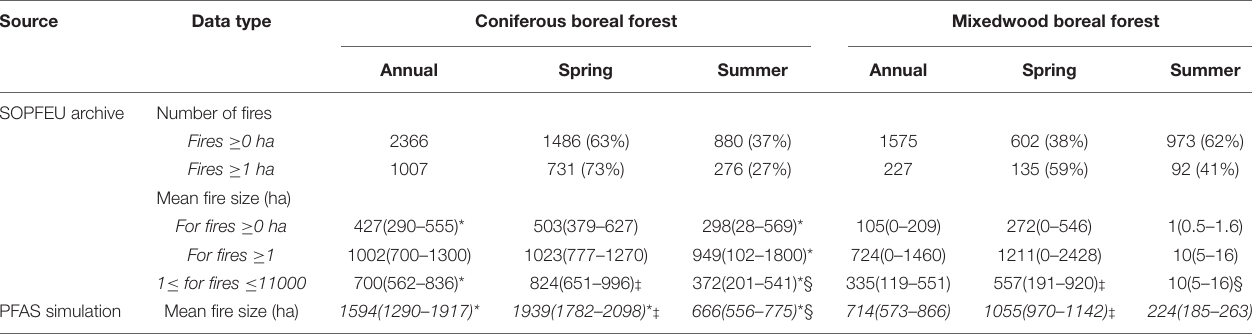
TABLE 1 | Observed vs. simulated annual and seasonal characteristics of fires in the boreal coniferous and mixedwood